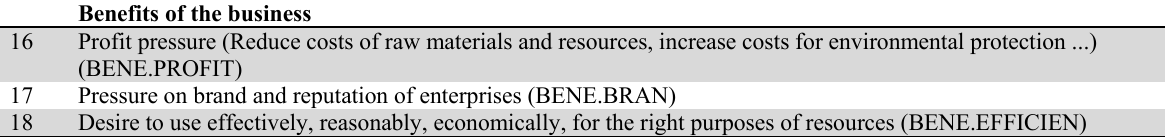
The Items of the sixth hypothesis: Benefits of the